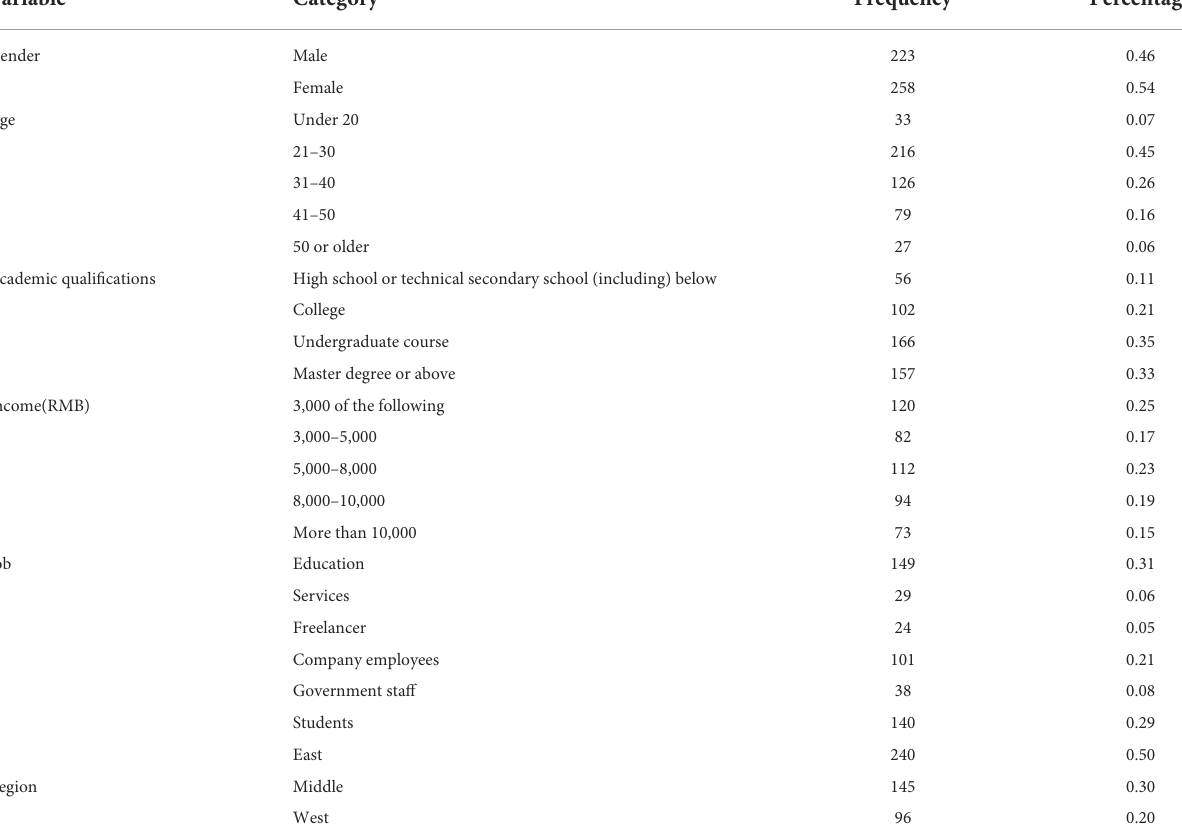
TABLE 3 Demographic profile of the participants.